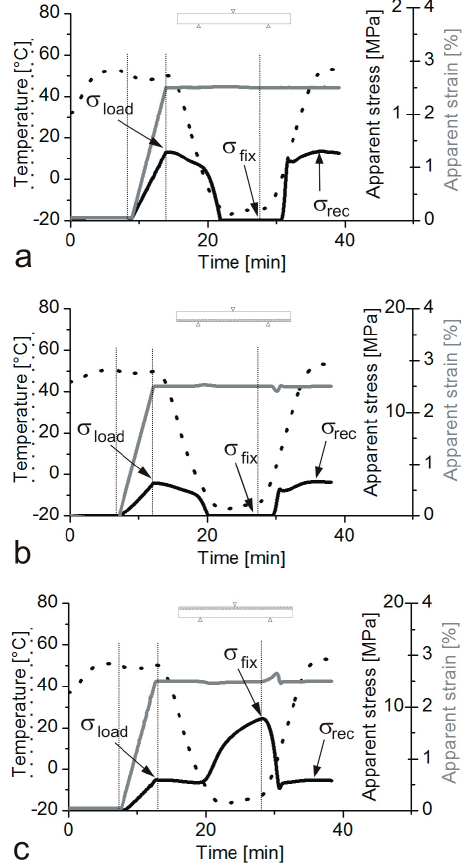
Figure 5. Shaping and unconstrained recovery of the neat EP ( a ) and its asymmetrically positioned CF-fabric ( b , c ) reinforced composites (containing two CF-fabric layers in the bottom and in the top, respectively) in bending (based on Ref. [156], reproduced with permission from BME-PT).